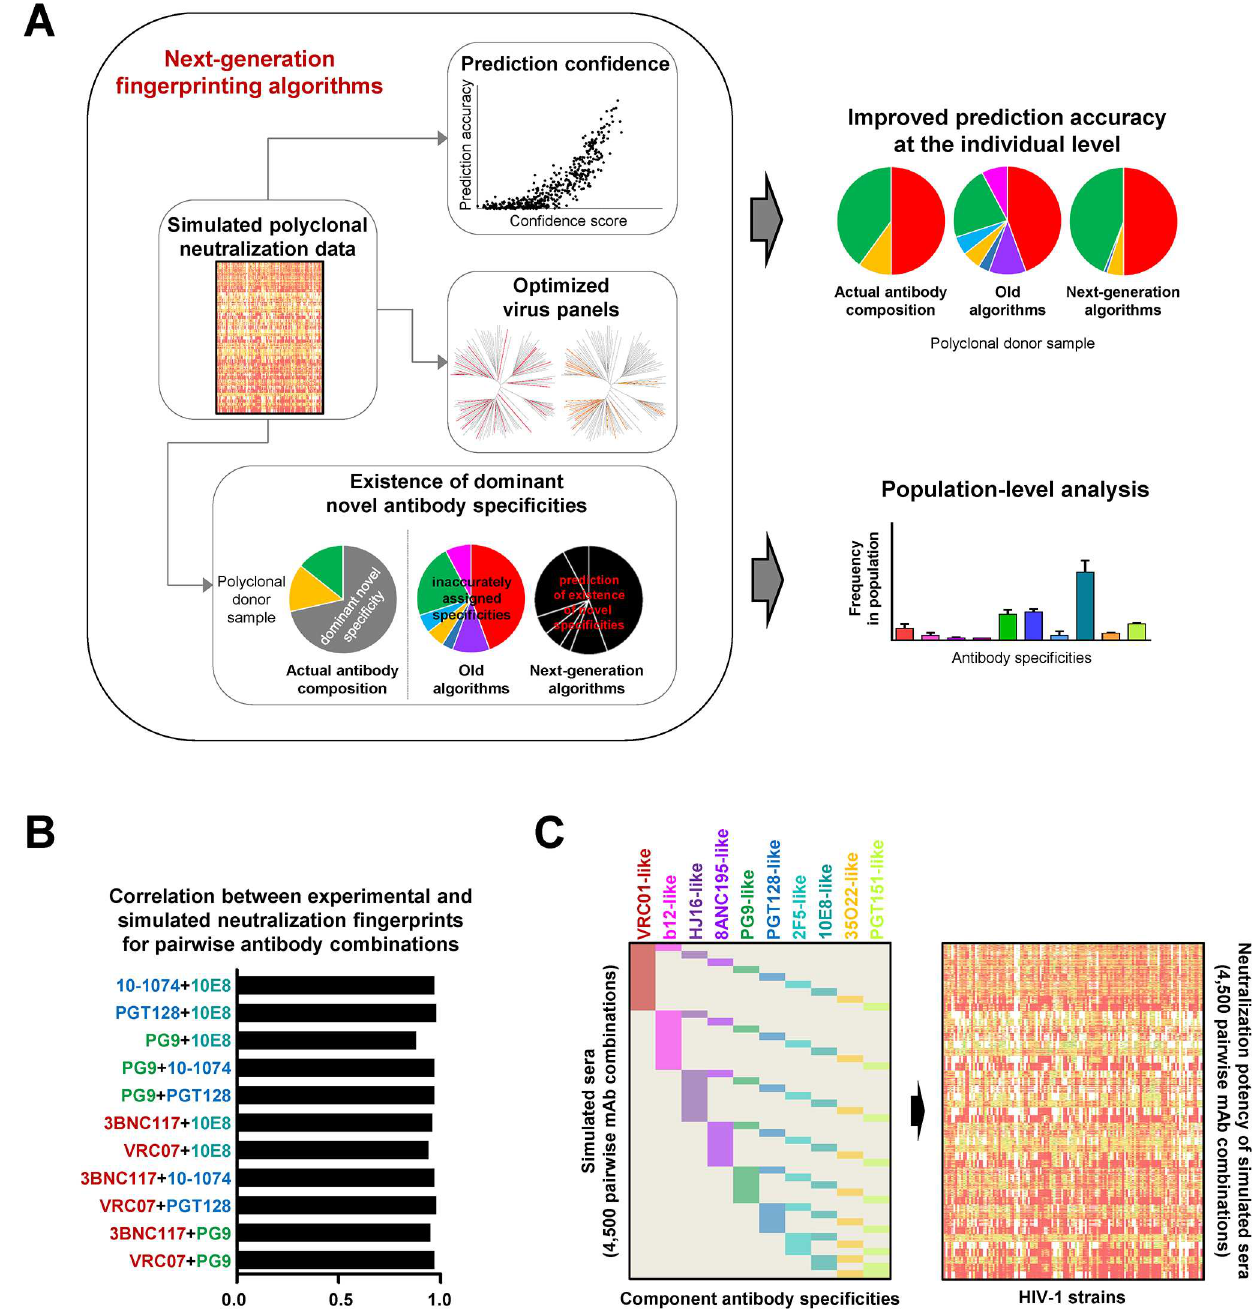
Fig 1. Next-generation neutralization fingerprinting algorithms for analysis of polyclonal responses against HIV-1. (A) Schematic of algorithmadvancesand applications. Large-scalesimulations of polyclonal neutralizationdata were used as a benchmark for the development of the different algorithmcomponents: algorithmsfor improved confidencein the computational predictions, for selectionof optimizedvirus panels, and for predictionof potentiallynovel antibodyspecificitiesin a serum neutralization signal. Together, these algorithms build the foundationfor improvingthe NFP predictionaccuracyat the individuallevel and enablingNFP analysisat the population(or cohort) level. (B) Spearmancorrelationcoefficients for simulatedvs. experimentally determined neutralizationdata for combinations of antibodypairs. Antibody names are colored accordingto the respective epitope-specific clusters from (C). (C) Large-scale simulationof polyclonalantibody neutralization, representedas a heatmapbasedon neutralizationpotency (white-green-yellow-red).